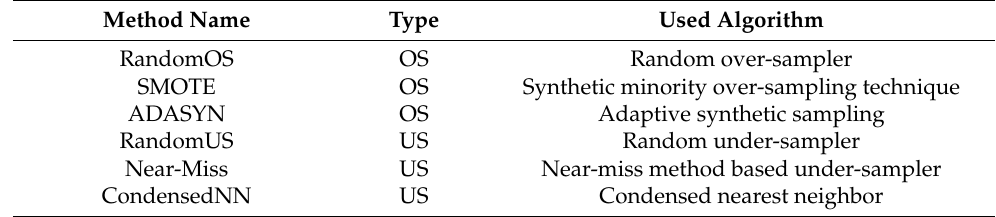
Table 3. Studied balancing methods.